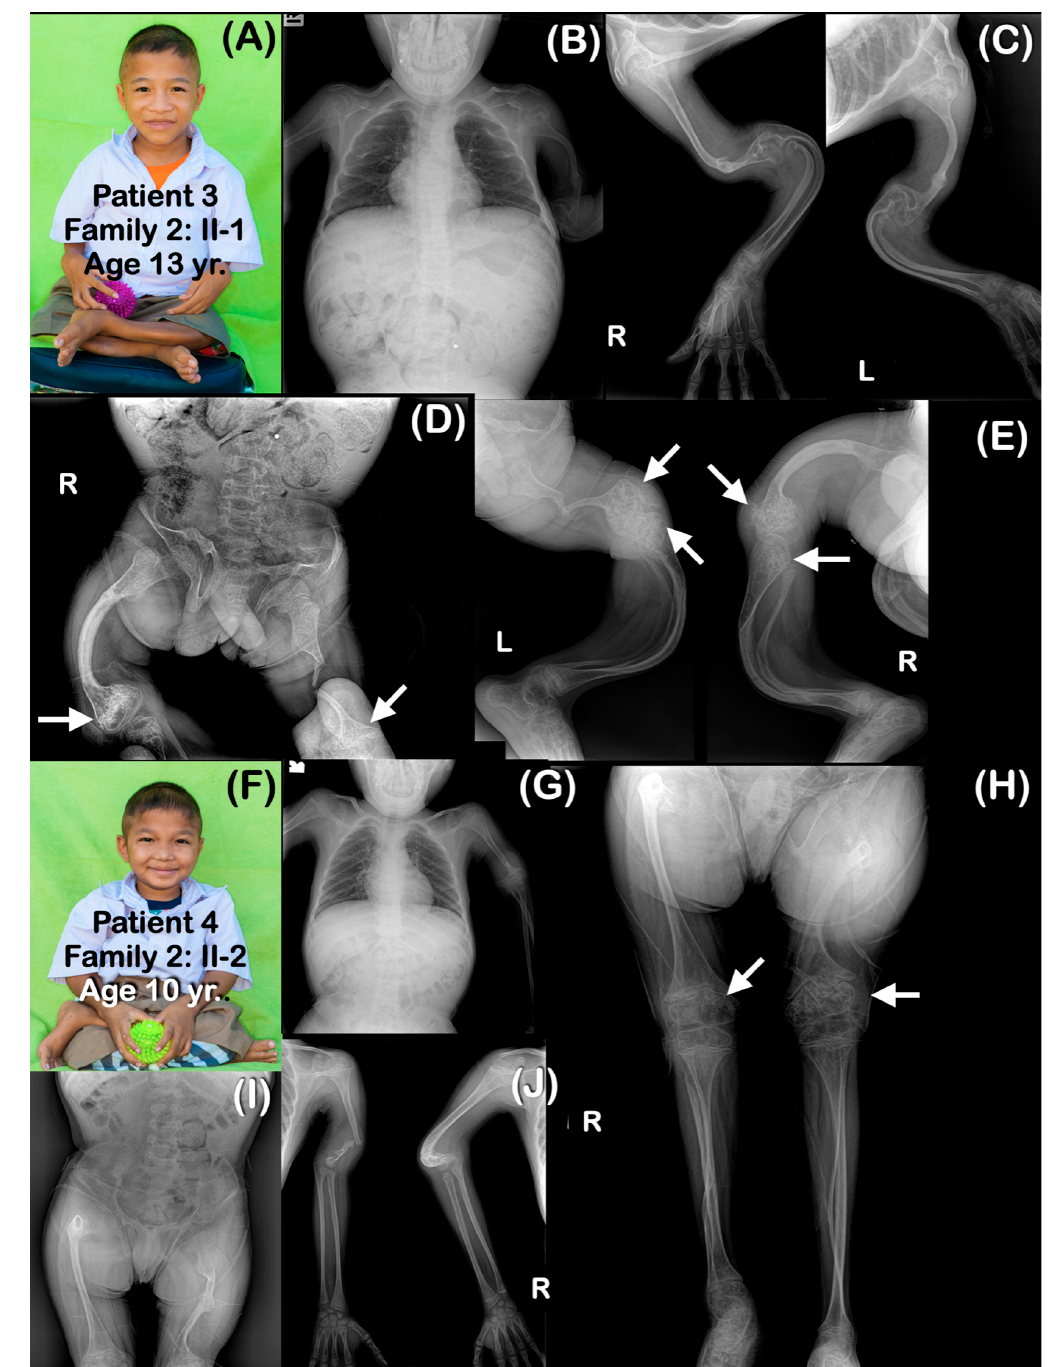
Figure 3. Family 2. ( A – E ) Patient 3 (Family 2: II-1). Age 13 years. Elder brother of patients 4 and 5. Generalized severe osteopenia. Severely dysplastic pelvis. The ribs are gracile (thin and slender). All long bones are severely slender and curved. Femora and humeri are shortened. ( D , E ) Popcorn epiphyses and metaphyses are observed at distal femora and proximal tibiae (arrows). Fractured humeri and right femur are healed. Left femur is severely shortened, and there is a fracture within proper healing in the middle part. ( F – J ) Patient 4 (Family 2: II-2). Age 10 years. Brother of patients 3 and 5. Generalized osteopenia. Severely dysplastic pelvis. All long bones are slender. Humeri and femora are shortened and curved. Fracture of left humerus is noted. ( H ) Large metaphyseal flare of distal femora and proximal tibiae is noted. Popcorn epiphyses and metaphyses are observed at distal femora